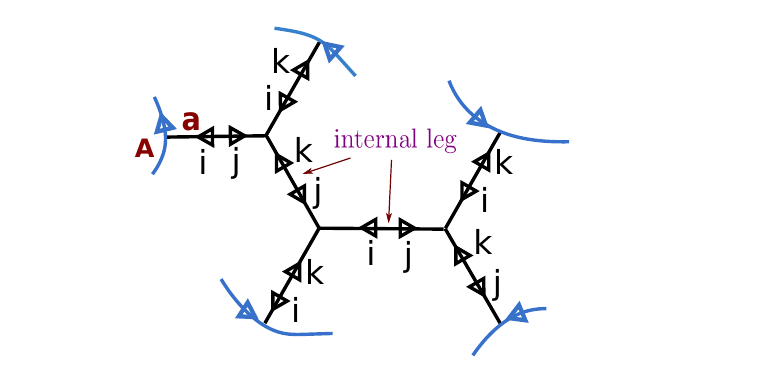
Figure 20 . An example of a trivalent tree (shown in black) with five legs attached to the link L (shown in blue). This trivalent tree has in total seven legs, two of which are internal in the sense that they are not attached to the link L